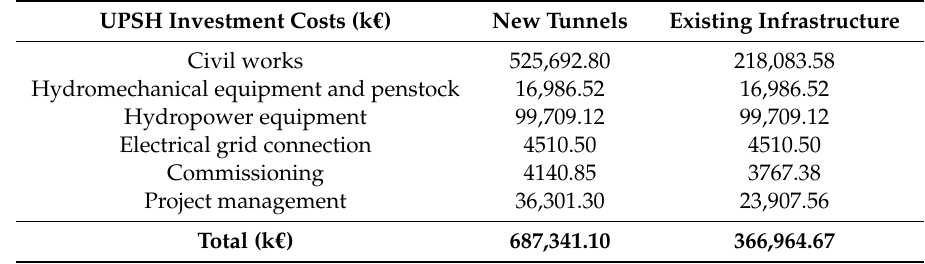
Table 1. UPSH investment costs analysis for construction of new tunnels or caverns and for making use of existing